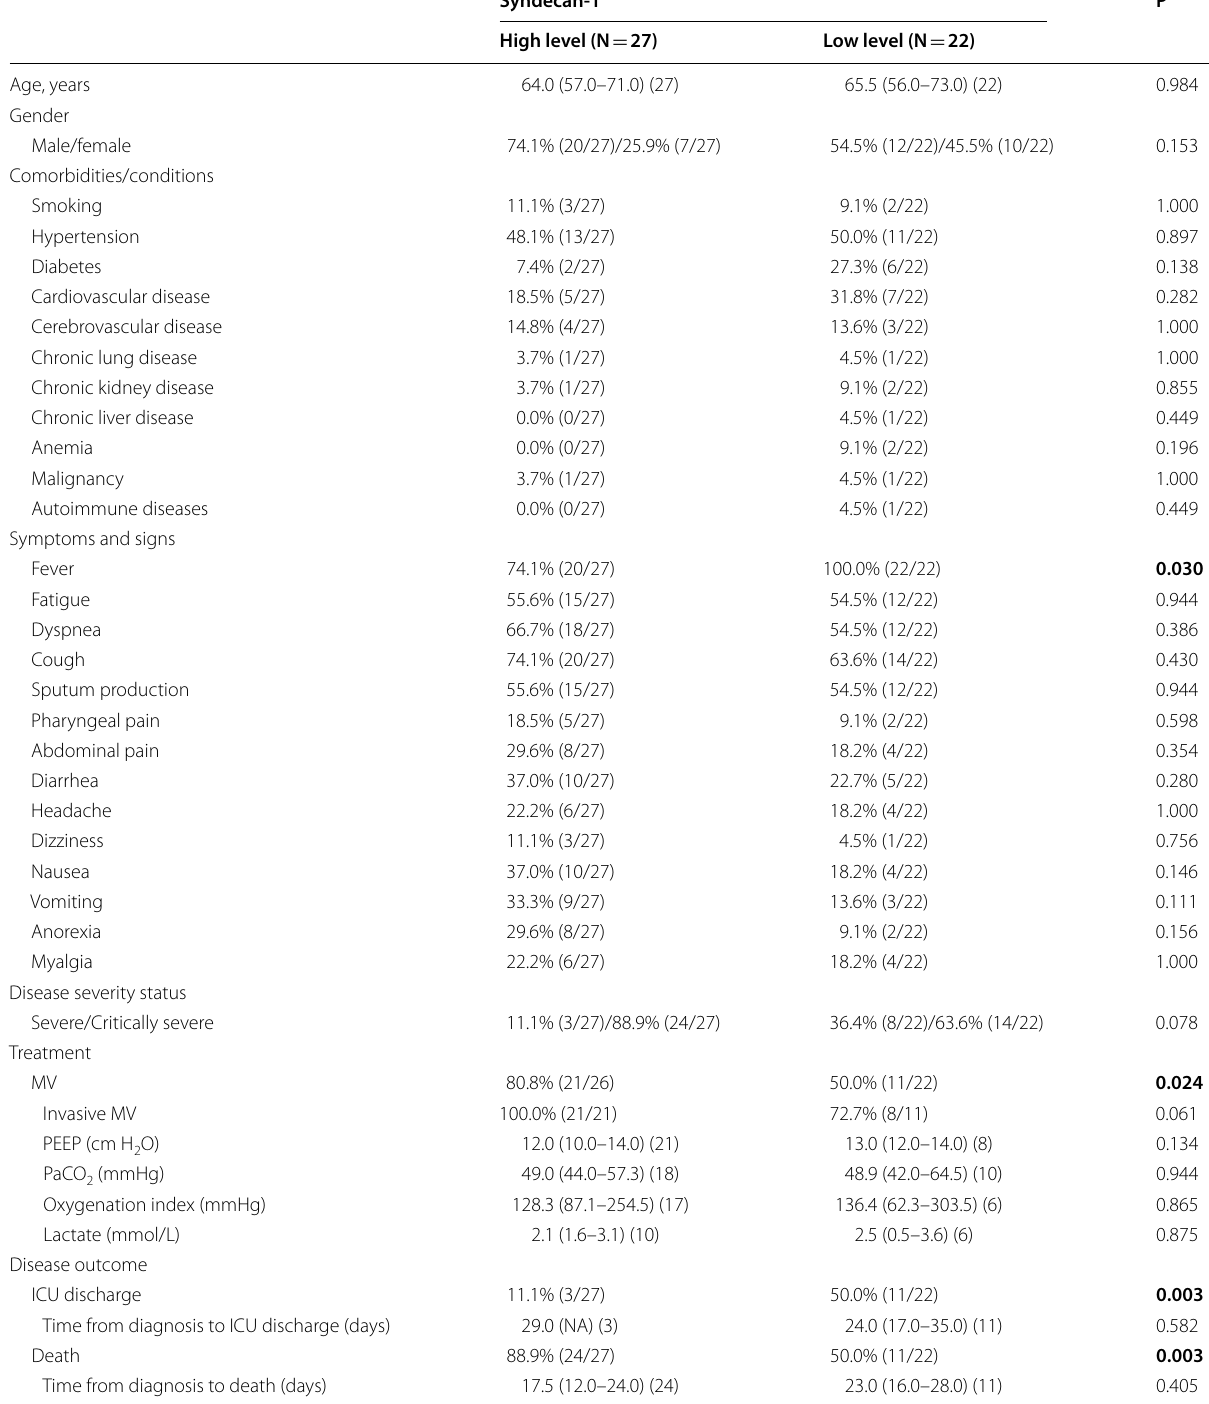
Table 3 Demographics, clinical characteristics, treatment, and outcome of COVID-19 patients stratified by Syndecan-1 level at